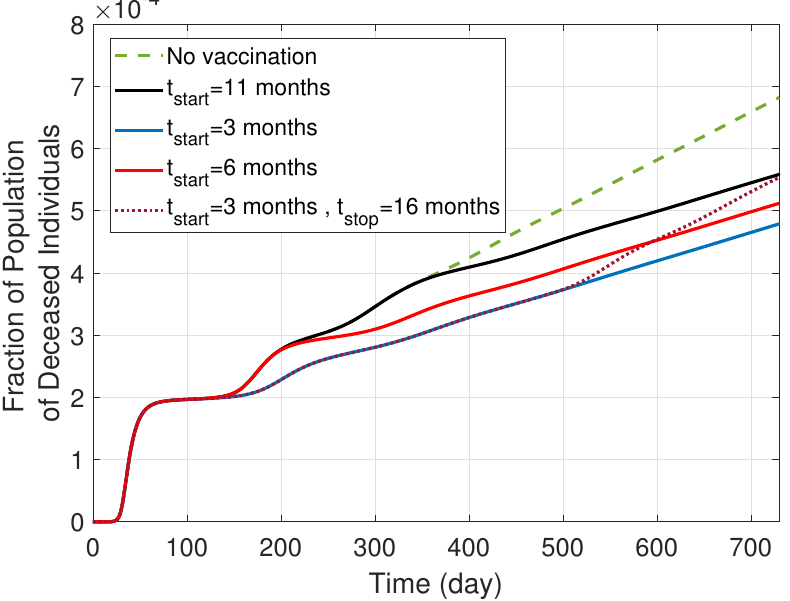
Figure 7. The total deceased in the SIRS model with different levels of severity and vaccination (i.e., the model depicted in Figure 5). Earlier vaccination leads to reduced deaths, and sustained vaccination ensures that the mortality rate is less than halting